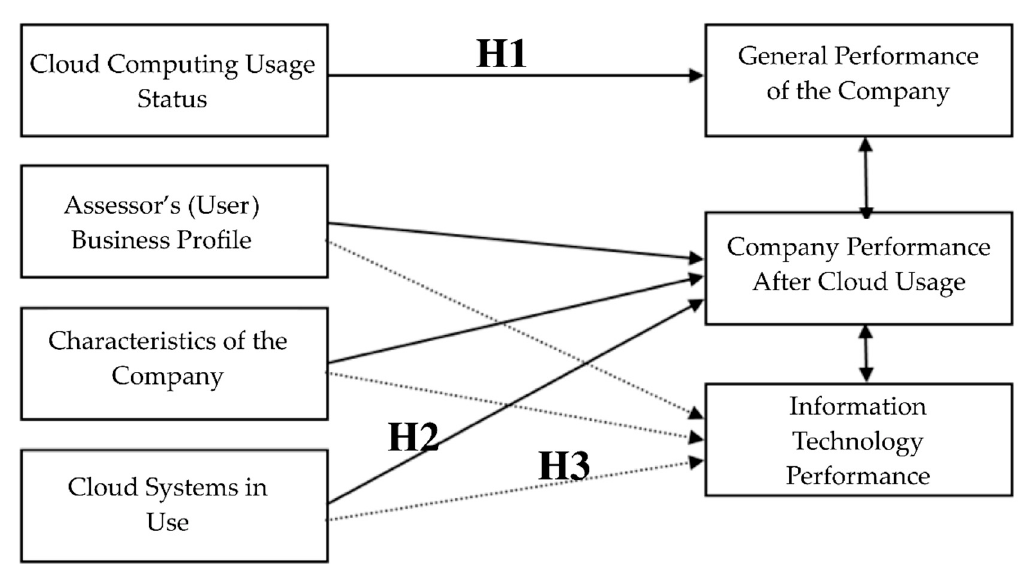
Figure 1. Research